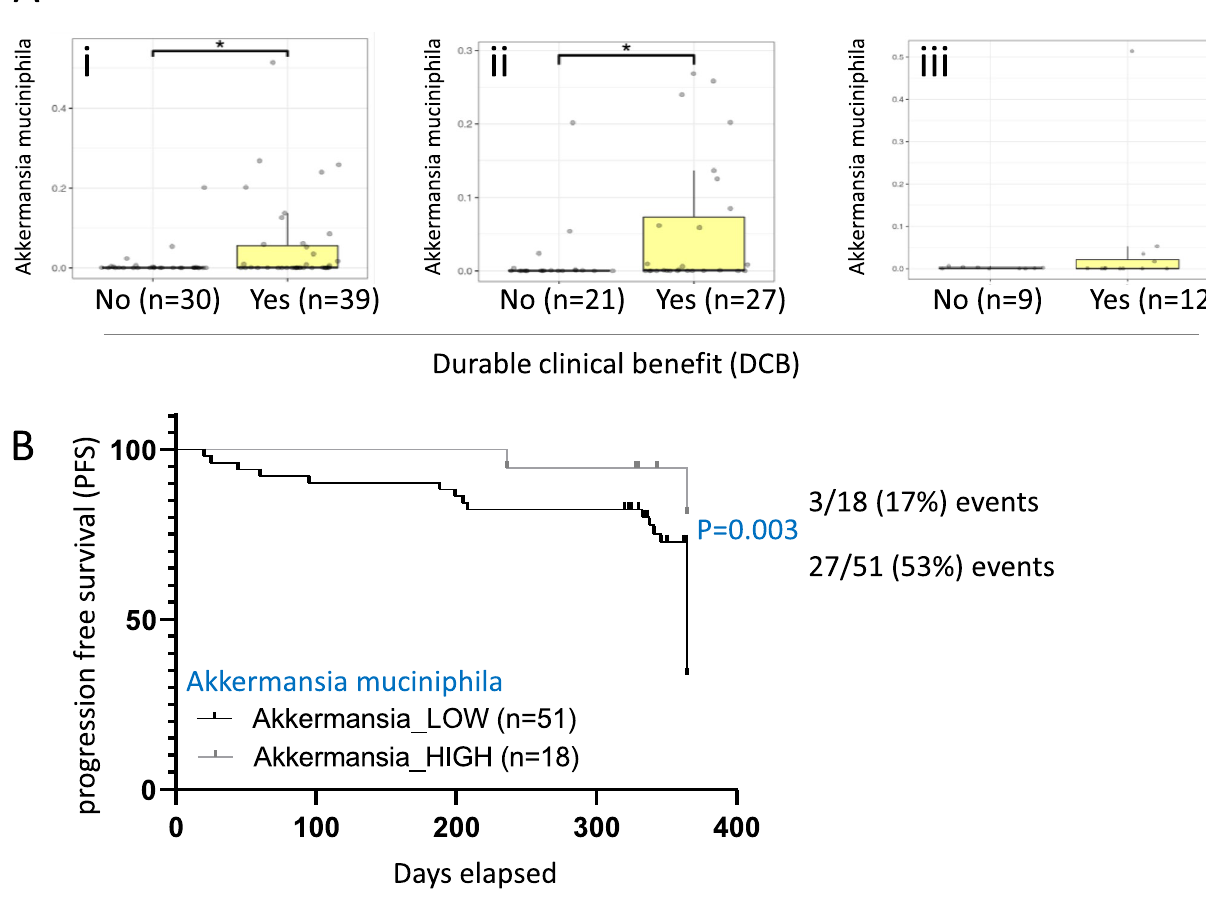
Figure 3. Higher Akkermansia muciniphila abundance is associated with durable clinical benefit (DCB). ( A ) Bar graph indicates pretreatment Akkermansia muciniphila abundance stratified by patients with and without DCB in all patients for which this data was available (n = 69; i), only in the group treated with immunotherapy (n = 48; ii), or the sub-group of LC patients not treated by CPIs (n = 21, iii). * Indicates p < 0.05 using t-test. ( B ) Patients with and without DCB for which this data was available (n = 69) were included. Youden point of 0.0074 was calculated to discriminate between those with and without DCB. Based on that value 69 patients were stratified to Akkermansia muciniphila low or high (above 0.0074) for Kaplan–Meier PFS analyses [Log-rank (Mantel-Cox) test P value = 0.003, and Hazard Ratio 4.26 (95% CI of ratio 0.0074 to best discriminate between DCB+ and DCB− patients and accordingly stratified the 69 patients with available data to Akkermansia muciniphila low or high, comparing them by Kaplan–Meier PFS analysis. The patients with high Akkermansia muciniphila had significantly higher odds for DCB [Log-rank (Mantel-Cox) test P value = 0.003, and Hazard Ratio 4.26 (95% CI of ratio 1.98–9.16)] (Fig. 3B). Specific ASVs linked with DCB after controlling for factors linked with microbial variance. To quantify the contribution of different factors affecting the gut microbial composition, we used a PERMANOVA test (Fig. 4; Dataset S4). PERMANOVA was applied after controlling for age and gender for each parameter, except when evaluating for the role of age and gender (in which cases we controlled for either gender or age). Figure 4A demonstrates the factors significantly linked to microbial variance as well as the level of explained variance. As expected, when including all samples of the LC group, inter-patient variance was the predominant factor. To control for the contribution of the subject, we limited our further analyses and included only one sam- ple per subject. Importantly, when only the first sample of each patient was included, as well as when focusing on patients that have received immunotherapy and on those that did not receive antibiotics, gender and DCB remain significantly associated with microbial composition while most other factors do not. Patients with and without DCB did not show differences in within-sample α-diversity (data not shown). However, multivariate analysis (using MaAsLin2) linking specific bacterial ASVs with DCB while controlling for gender, age, and accounting for samples from the same subject identified four ASVs that remain significantly correlated with DCB (after controlling also for age and gender, Fig. 4B,C, Dataset S5). Those included higher Alistipes indis- tinctus (ASV03617), Ruminococcus (ASV08171) and Alistipes onderdonkii (ASV05119) in those with DCB and higher Clostridium citroniae (ASV09473) in those without DCB.